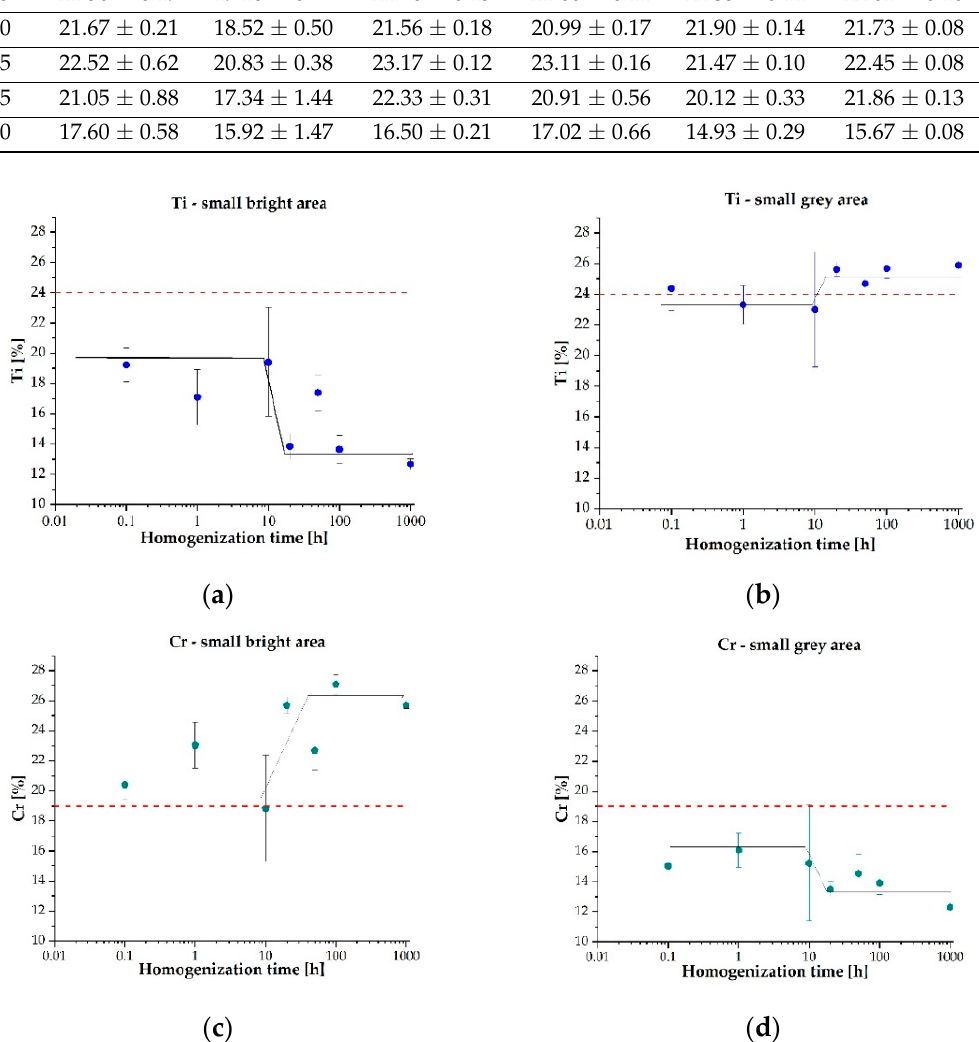
Figure 6. An example of a large light phase area (lb) subjected to EBSD microdiffraction ( a ) in the form of the Kikuchi line for the BCC crystal lattice with the lattice parameter oscillating around the value characteristic for the manganese lattice ( b ).